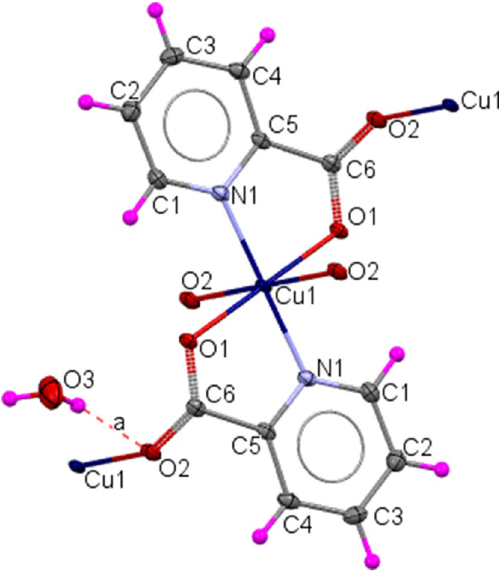
Fig. 1 Thermal ellipsoid plot (ORTEP) view of CP-1 showing all atoms and